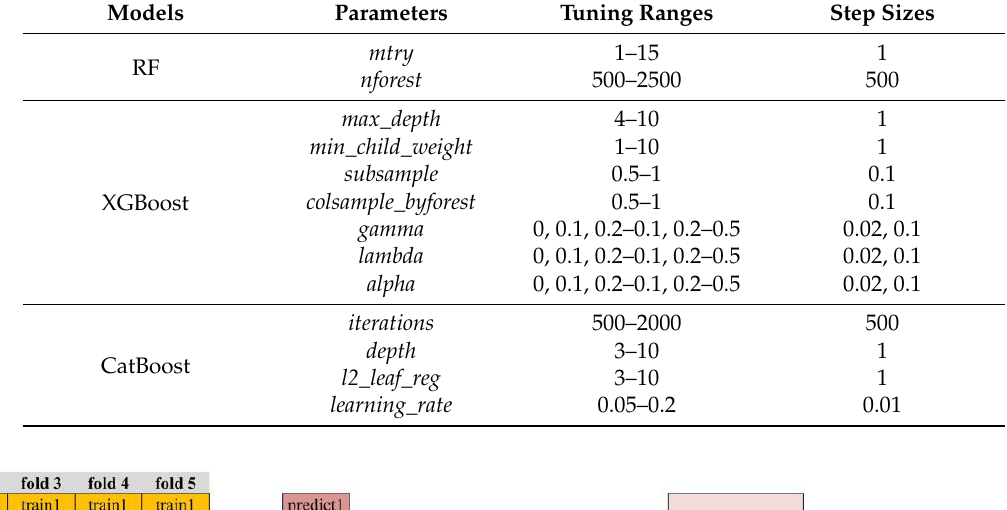
Table 6. Tuning parameters of classification models.